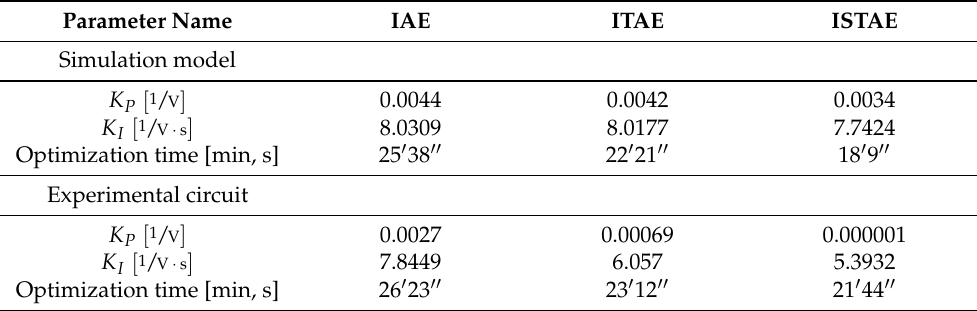
Table 6. Calculated values of PI regulator K P and K I gains together with their GA computation times where the GM was constrained by GM = (cid:104) 10,20 (cid:105) dB and PM = (cid:104) 80,90 (cid:105) ° GM shown in Figure 7 for simulation and in Figure 8 for experiment.